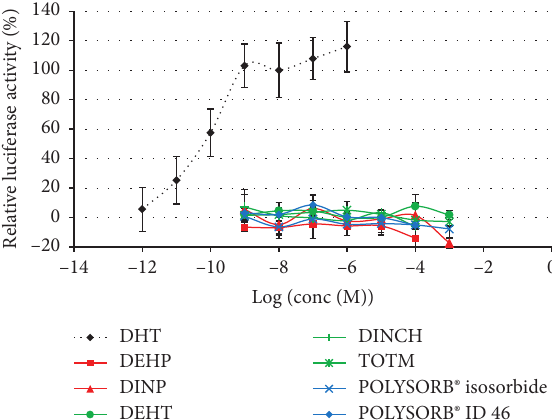
Figure 5: Androgenic activity of phthalates and substitutes in MDA-kb2 cells. MDA-kb2 cells were exposed for 20–24h to different concentrations of DEHP, DINP, DEHT, DINCH, TOTM, POLYSORB ® isosorbide, or POLYSORB ® ID 46. Results represent the mean relative luciferase activity compared to DHT 10–8M ( � 100%) ± SD of 3 replicates from one representative assay out of 2